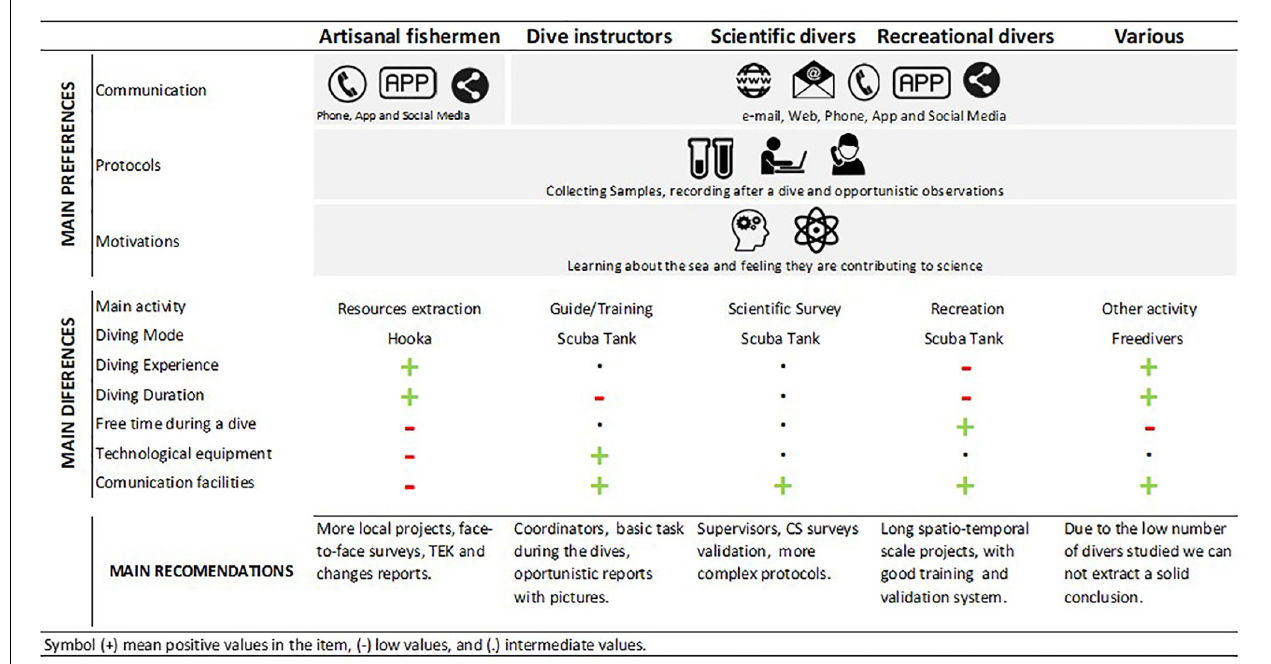
FIGURE 3 | Main preferences and differences between diver types and recommendations for each, based on the results of the present study.